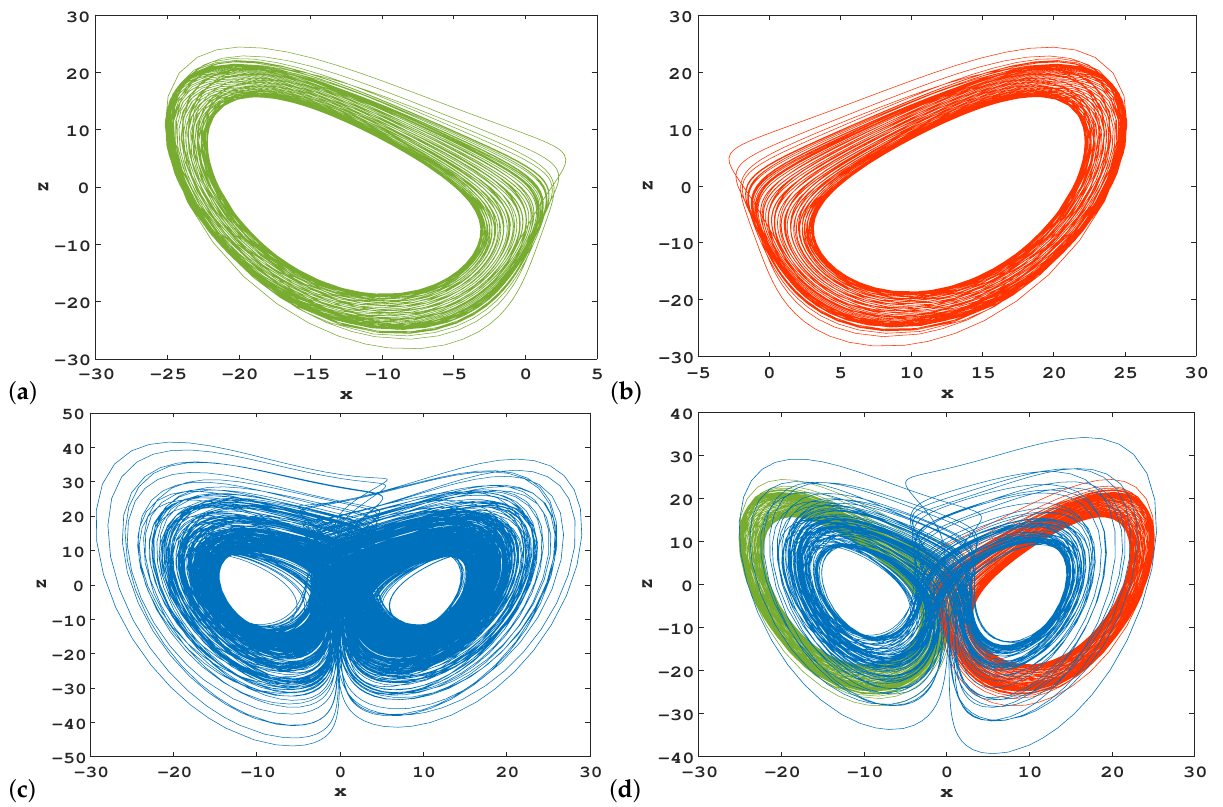
Figure 12. Three coexisting hidden hyperchaotic attractors of system (2); ( a , b , c , k , m ) = ( 10,70,2.7, − 0.2,5 ) ; ( a ) asymmetrical hyperchaotic attractor; ( b ) the other asymmetrical hyperchaotic attractor; ( c ) symmetrical hyperchaotic attractor; ( d ) coexisting hyperchaotic attractors. The green line, the red line and the blue line correspond to the hyperchaotic attractor shown in ( a – c ), respectively.